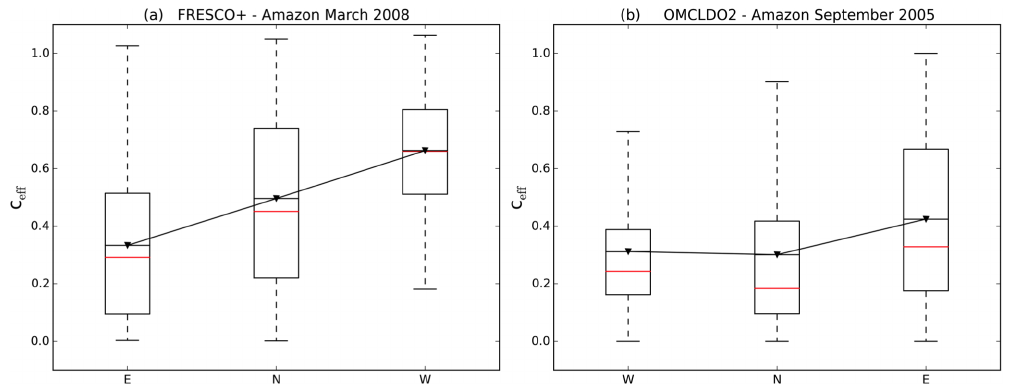
Figure 2. Box plot of cloud fractions retrieved with (a) FRESCO cloud retrieval for GOME-2A for March 2008 and (b) OMCLDO2 cloud retrieval for OMI for September 2005 for east–nadir–west measurements over Amazonia (lat: 5 ◦ N–10 ◦ S, long: 60–70 ◦ W). Black triangles correspond to mean values, red lines to median. The box represents 25th and 75th percentiles and the dashed lines the minimum and maximum